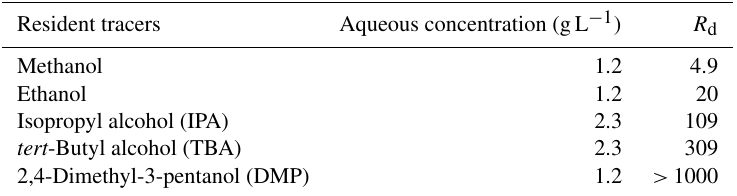
Table 1. Resident tracers per litre of aqueous solution and their partitioning characteristics. Retardation factors ( R d ) for the specific set of tracers and AC used in this study had previously been determined by Cho et al.